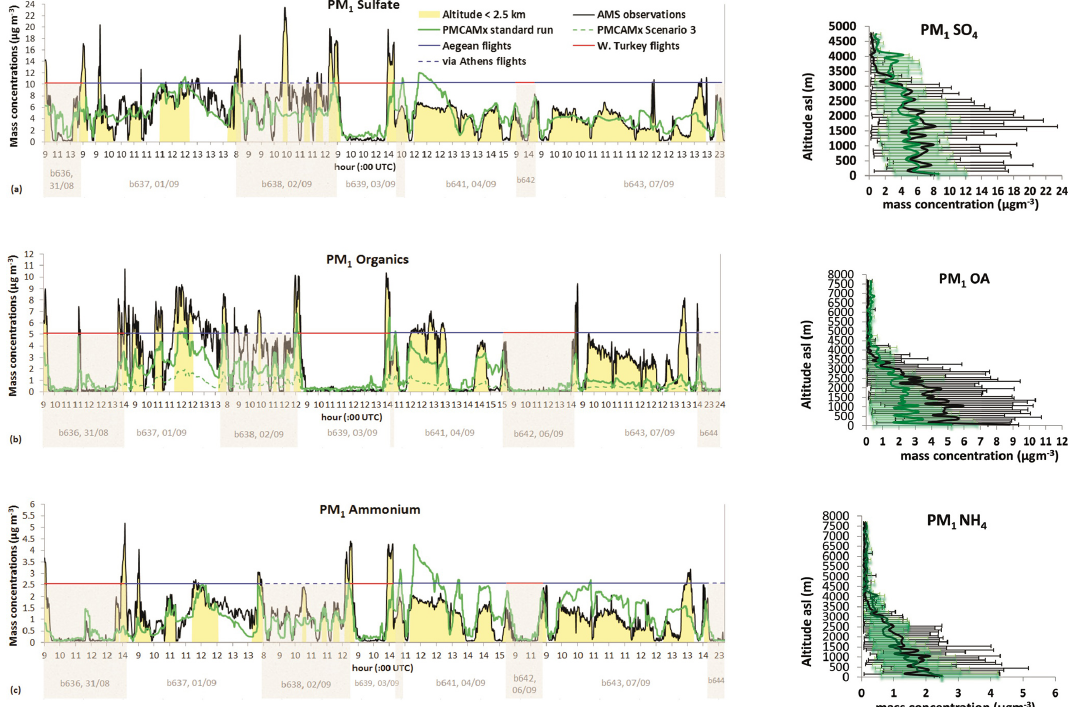
Figure 2. Comparison of PMCAMx results (green continuous line) with AMS airborne measurements (black continuous line) for total PM 1 : (a) sulfate; the legend applies for all succeeding graphs, (b) organics (green dashed line for scenario 3 is also shown), (c) hourly particulate ammonium concentrations (µgm − 3 ) for all flights in the frame of the AEGEAN-GAME, ACEMED, CarbonExp and CIMS campaigns, during 31 August–09 September 2011. Data from the flights over the Aegean Sea, via Athens and over west Turkey are discriminated by the horizontal blue, dashed-blue and red lines, respectively. The yellow shaded area indicates mass concentrations below 2.2kma.s.l. The flight numbers and dates are shown at the bottom. More detailed flight information is embedded in Fig. 1. On the right of each graph, the vertical profile of each species averaged per 100m (error bars with minimum and maximum values) is